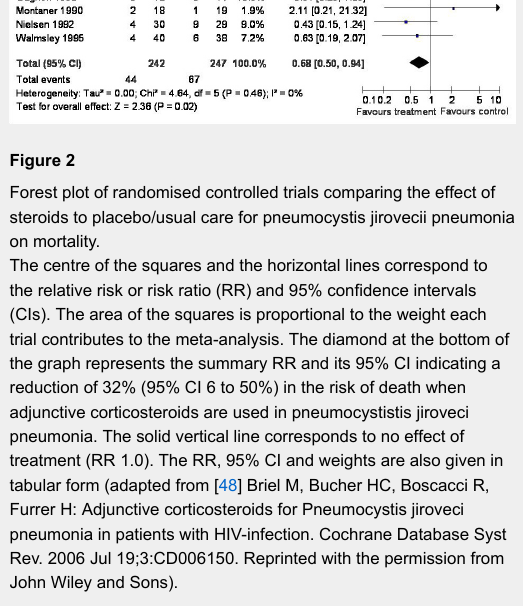
Table 1: Comparison of narrative and systematic reviews. Feature Narrative review Question Search strategy Selection criteria Absent Methodological appraisal of primary studies Possible/No Synthesis of